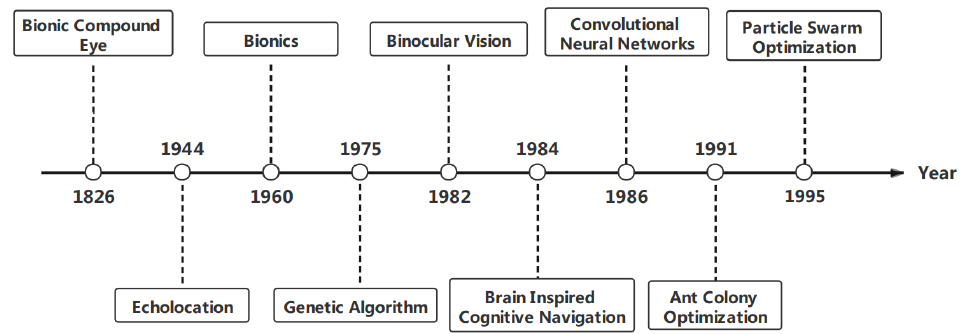
Figure 9. The timeline of research on bionic